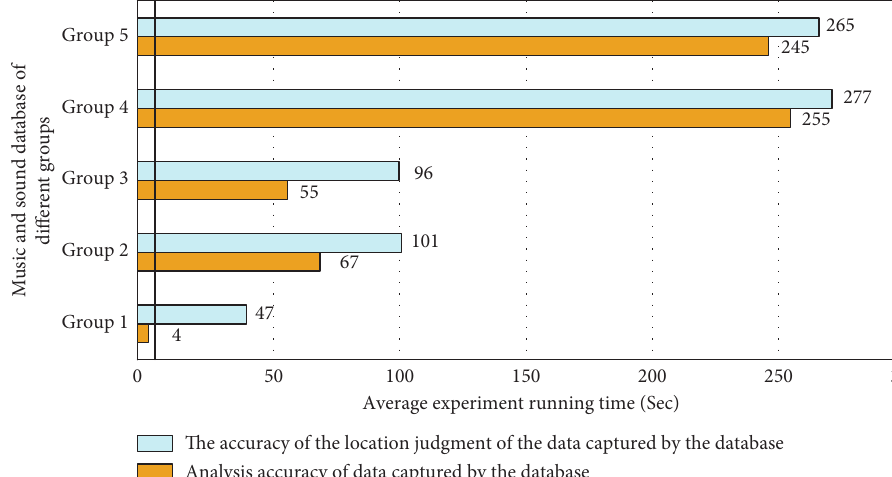
Figure 9: Analysis of experimental results of the deep learning neural